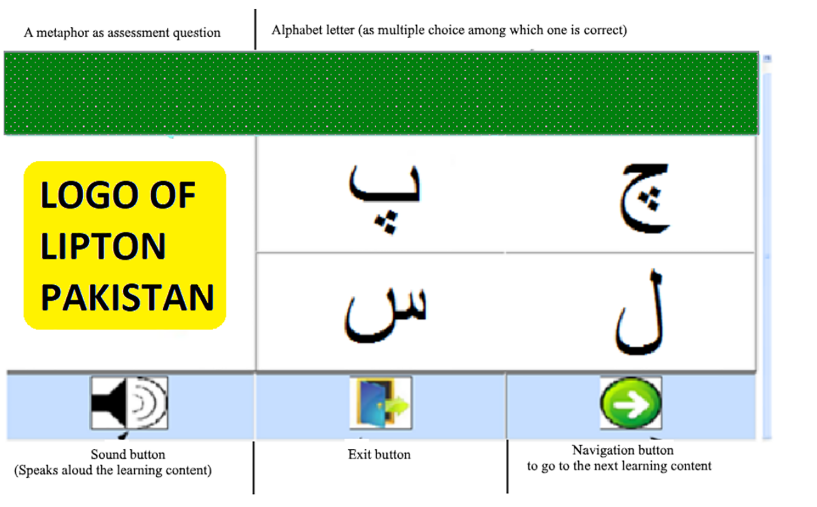
Fig 2. Computer-assisted assessment application using